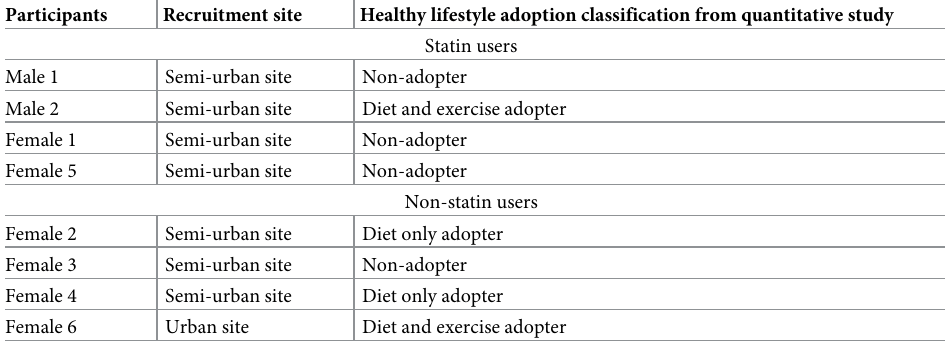
Table 7. Characteristics of interviewees in qualitative